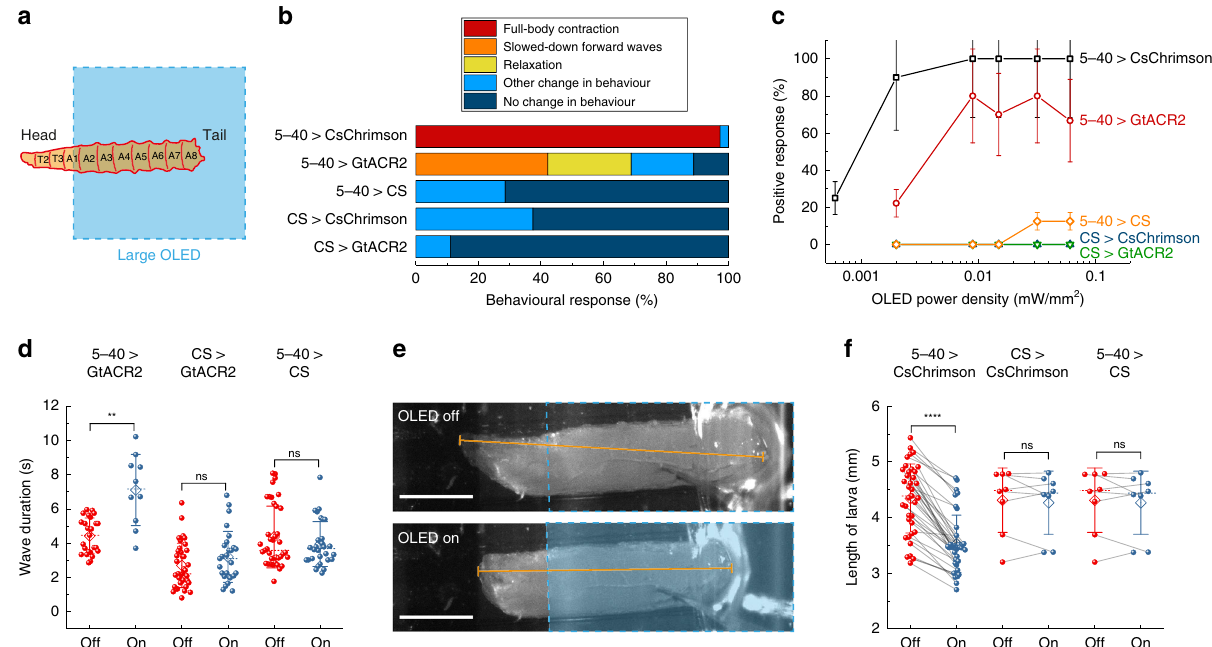
Fig. 3 Behavioural response upon whole-animal activation/inhibition of sensory neurons using a large OLED. a Sketch illustrating the placement of larvae on the 4 × 4 mm 2 OLED. b Behavioural response upon photostimulation at 15 µ W mm − 2 . n = 17 larvae for 5 – 40 > CsChrimson; n = 20 for 5 – 40 > GtACR2; n ≥ 7 for controls (5 – 40 > CS, CS > CsChrimson, CS > GtACR2). c Dose – response curve, counting either full-body contraction, slowdown of muscle contraction waves or relaxation as a positive response. Larvae expressing 5 – 40-GAL4> CsChrimson were stimulated for 3 s with a 12 s break before moving to the next higher intensity; all other larvae were stimulated for 10 s with 10 s breaks (Supplementary Movies 1 – 3). Data show mean ± SEM; n ≥ 7 larvae. d Wave duration of GtACR2-expressing larvae and controls with and without light application at intensities ranging from 2 to 15 µ W mm − 2 showing individual values (spheres), mean (diamond), median (dashed line) and SD (whiskers); each sphere indicates a trial; n ≥ 6 larvae for each condition. e , f Analysis of larval length before and after photostimulation at 15 µ W mm − 2 for CsChrimson-expressing larvae and controls. e Examples of images used for length measurement. Top: frame recorded immediately before OLED turn-on; bottom: 0.5 s after OLED turn-on. The blue-dashed line outlines the OLED pixel; the orange line indicates the length measurement. Scale bars: 1 mm. f ) Statistical comparison of larval length; n = 17 larvae for 5 – 40 > CsChrimson, n ≥ 7 larvae for controls. Two-tailed t test: n.s. not signi fi cant ( P > 0.05), ** P < 0.01, **** P <